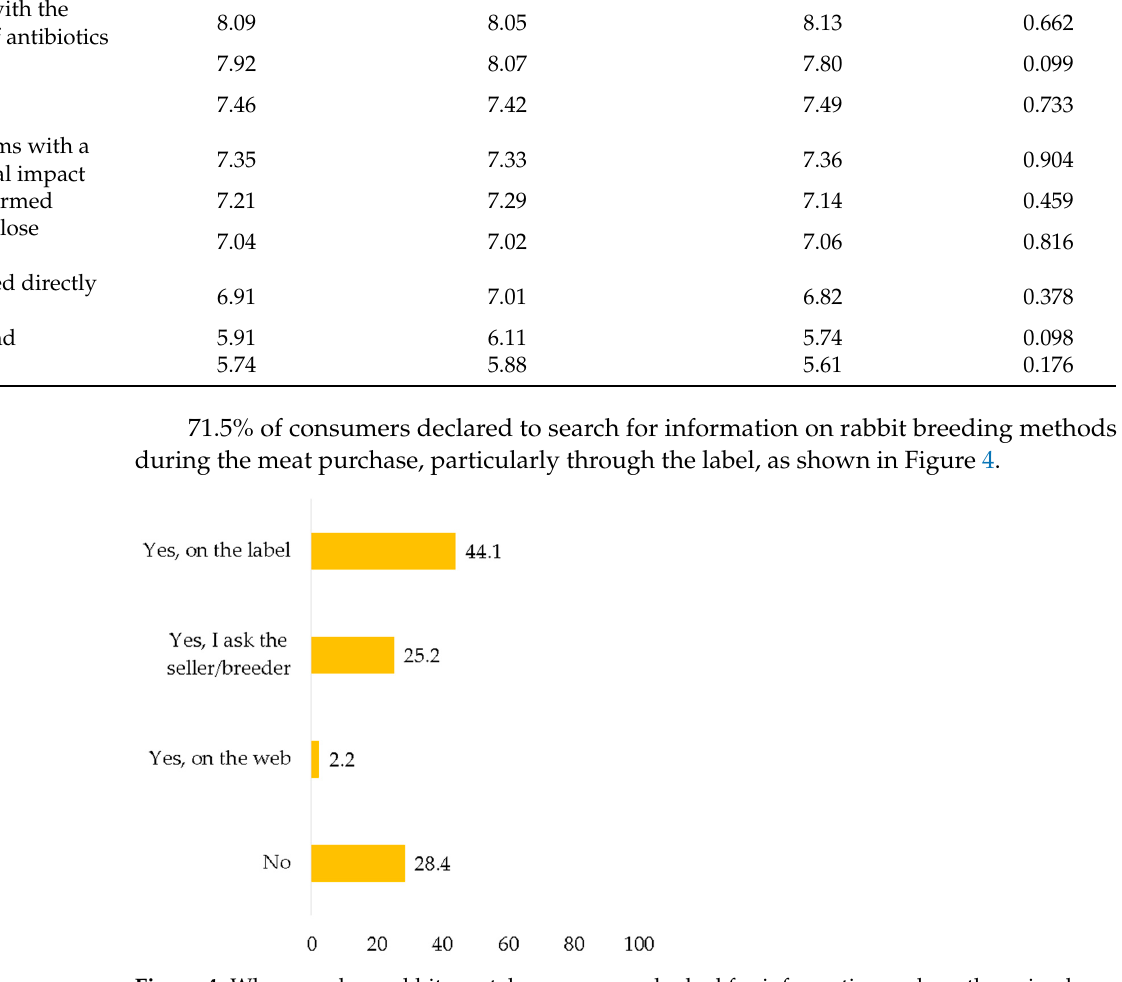
Figure 4. When you buy rabbit meat, have you ever looked for information on how the animal was raised? (%, n =